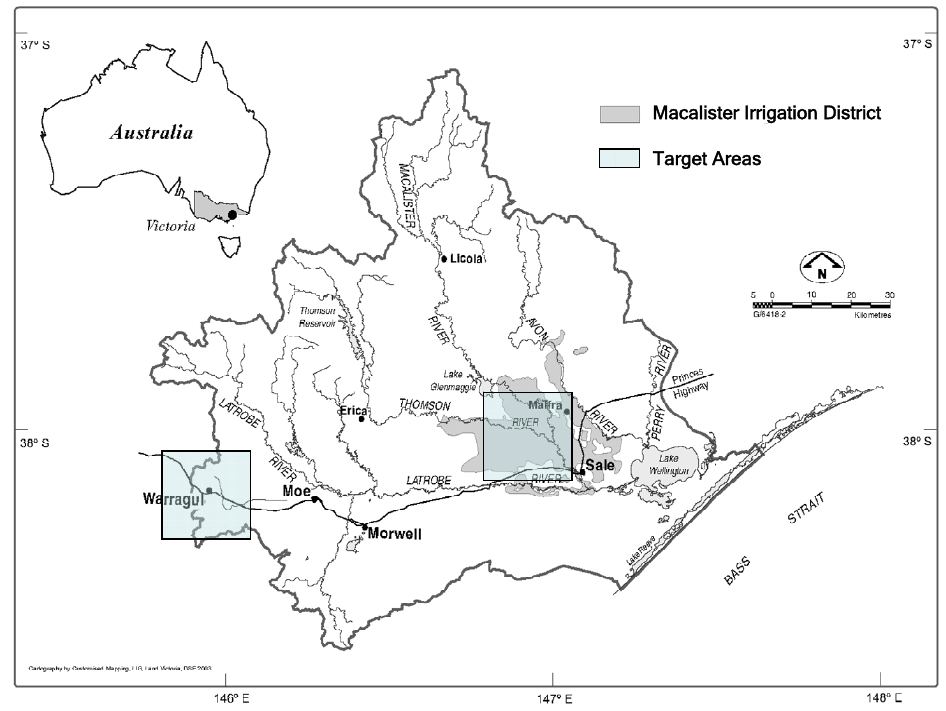
Figure 1. Selected sampling areas within the Gippsland region of south-eastern Victoria. Adapted from Nash [37].